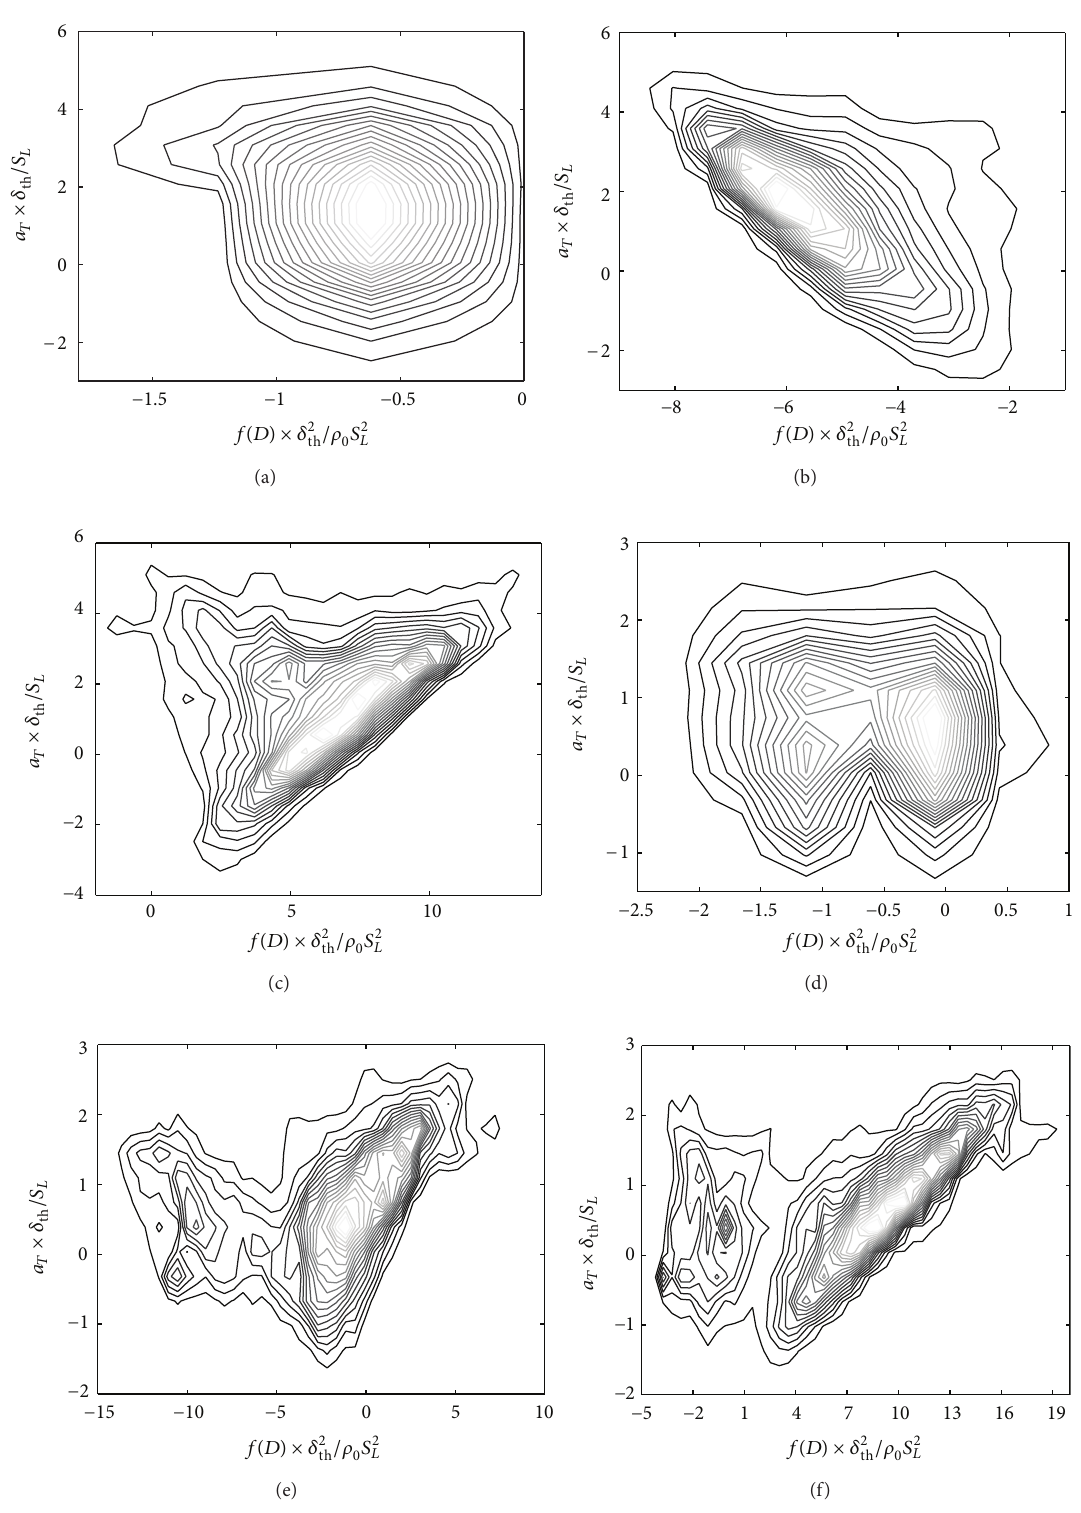
/𝜌 𝑆 2 0 𝐿 and normalised tangential strain rate th